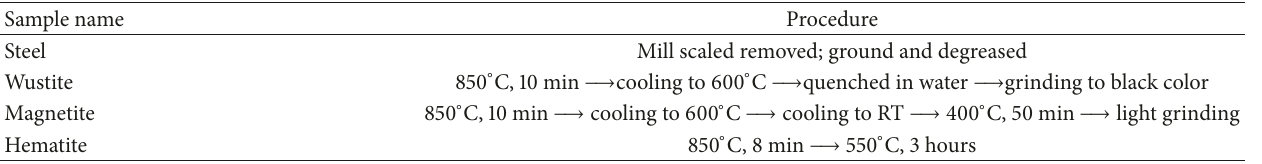
Table 2: Manufacturing procedure of the different